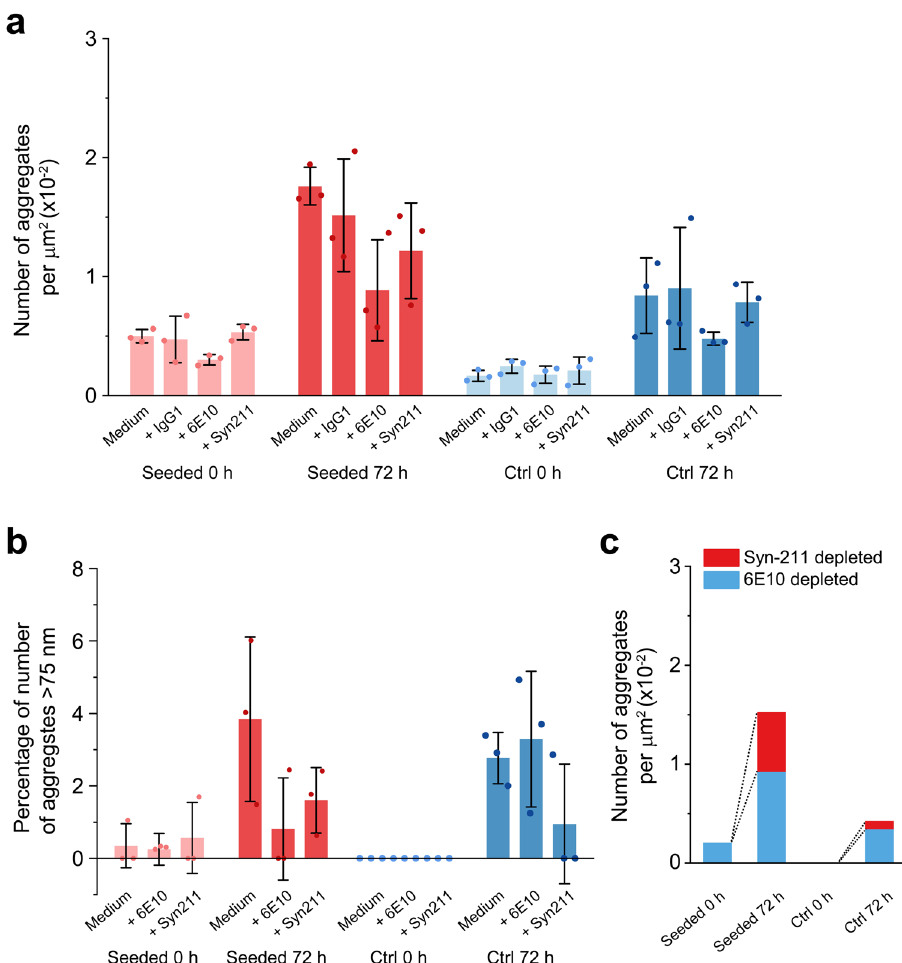
Fig. 4 Seeded cells secrete high levels of A β and α -syn aggregates. Immunodepletion of A β and α -syn from culture medium was carried out using 6E10 or Syn211 antibody. The immunodepleted media were then imaged with AD-PAINT. a Number of aggregates per µ m 2 after immunodepletion. b Percentage of aggregates >75 nm in the detected population. c Numbers of aggregates removed by depletion with antibodies against A β and α -syn at de fi ned time points. The numbers were calculated using the mean values of medium only controls and immunodepleted media as shown in a . Secreted aggregate of both A β and α -syn accumulate over